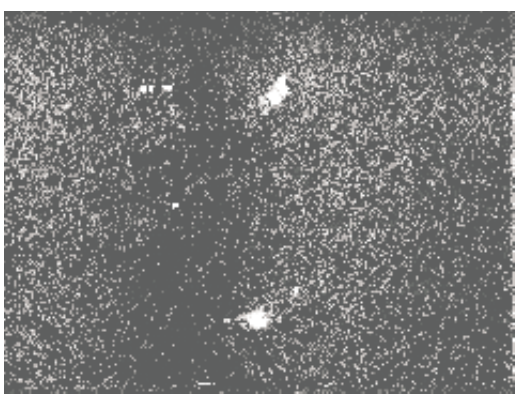
Fig. 8 – Image of the laser beam at the beginning of the pulse, approximately at 90msec of current flow.